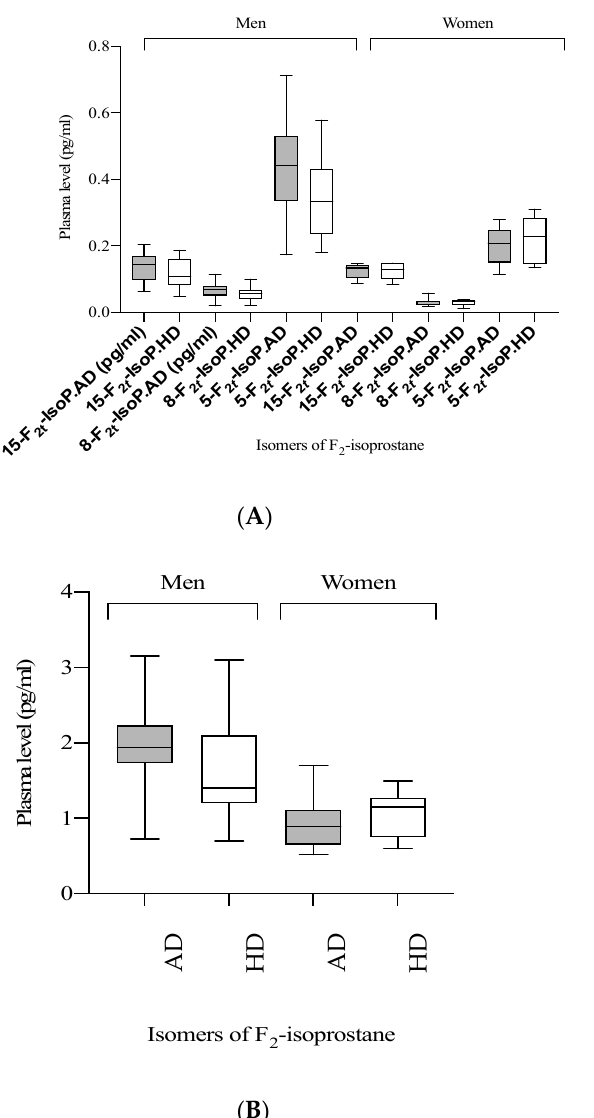
Figure 2. Boxplot of estimated marginal means of difference in the plasma level of F2-IsoP (ng/mL) according to sex after high-dairy (HD) and adequate-dairy (AD) diet interventions. ( A ) levels of specific F 2 -IsoP isomers and ( B ) sums of all F 2 -IsoPs. Generalized linear mixed model (GLMM) analyses with two covariates (BMI and sex), repeated statements (visit).